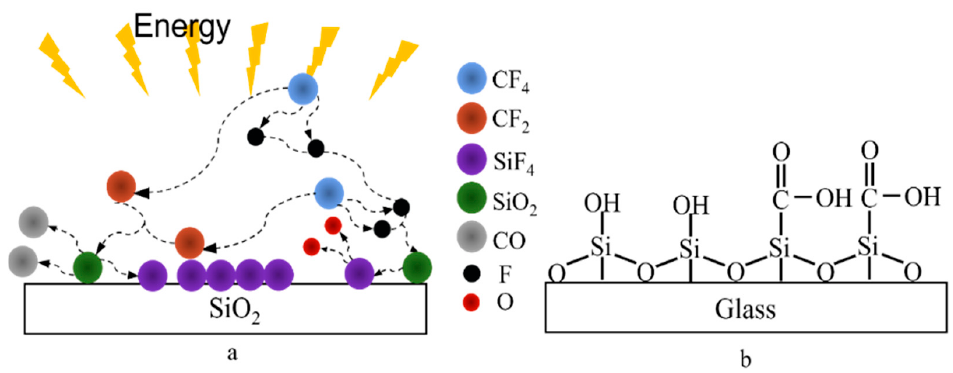
Figure 8. ( a ) Introducing F-containing functional groups into the surface of SiO 2 treated by plasma; ( b ) plasma-treated glass surface grafted with O functional groups.